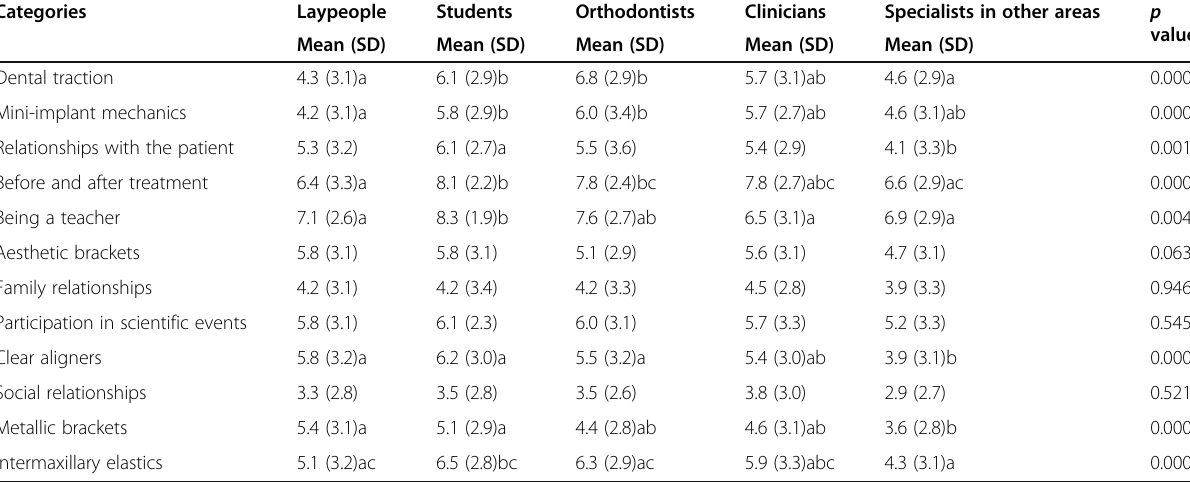
Table 1 Results of the mean score for perception of credibility between groups, according to the different categories of the posts Categories